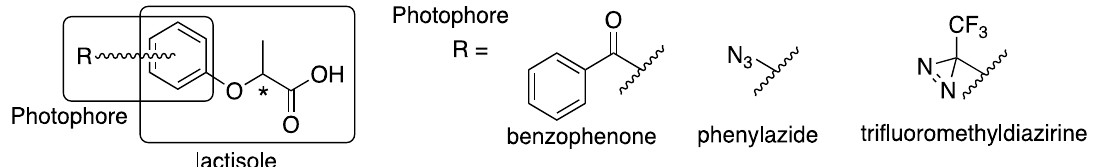
Figure 1. Structures of photoreactive lactisole derivatives in this study.